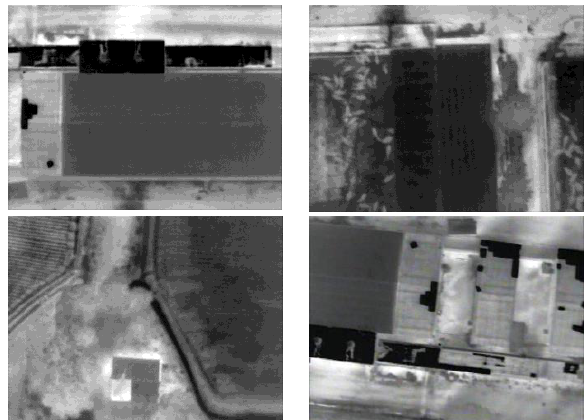
Figure 4: Frame extracted from thermal video